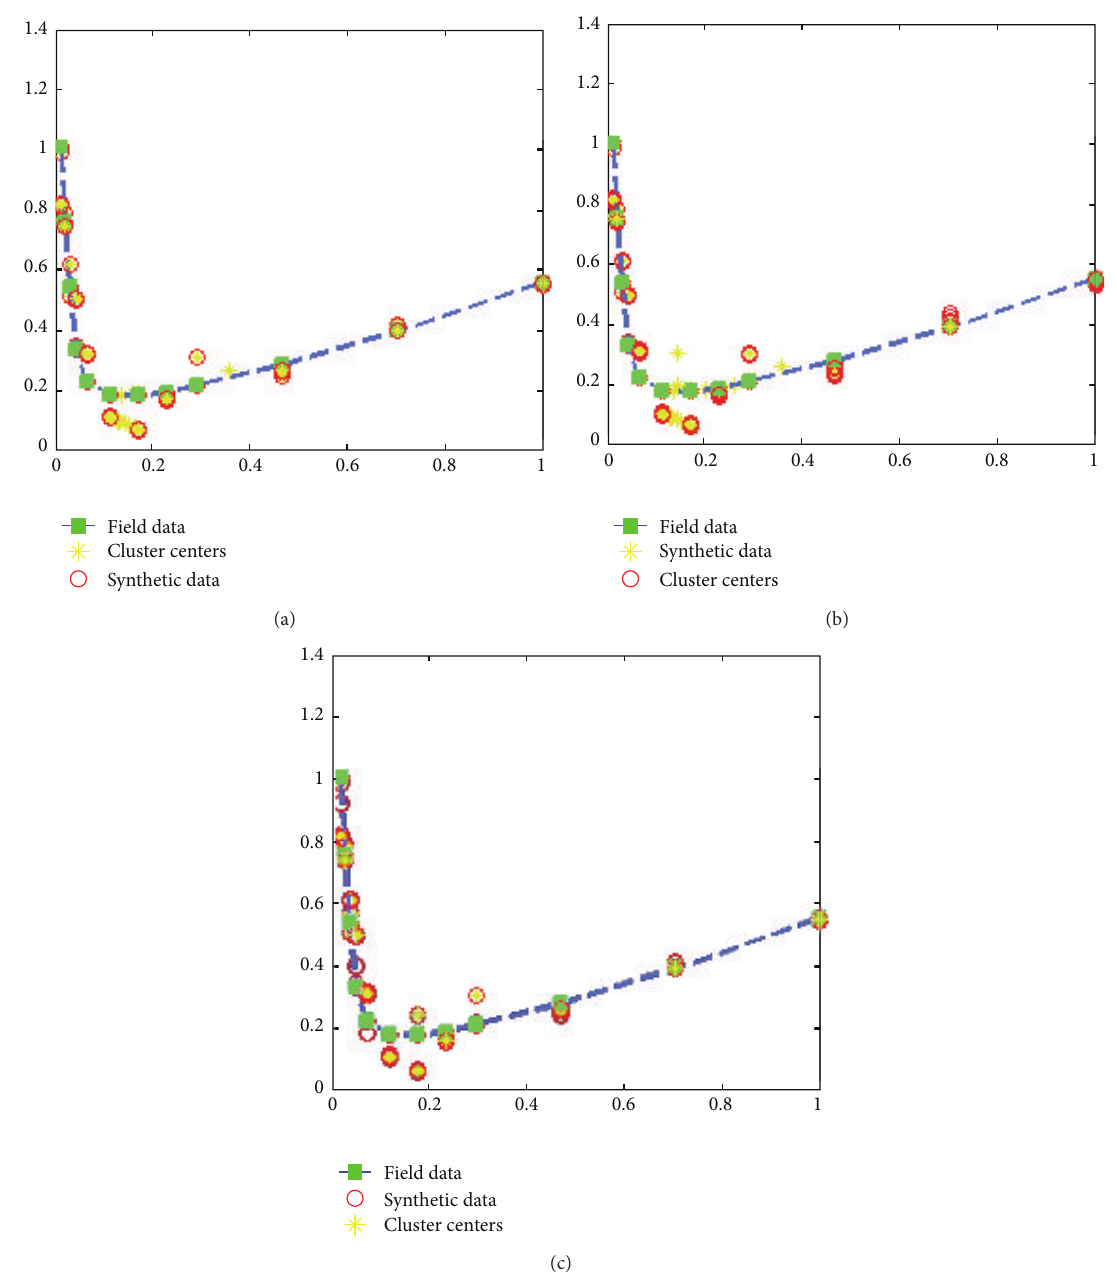
Figure 8: Formation of fuzzy cluster centers while interpreting data 2: (a) fuzzy 𝐶 -means clustering, (b) fuzzy 𝐾 -means clustering, and (c) fuzzy subtractive